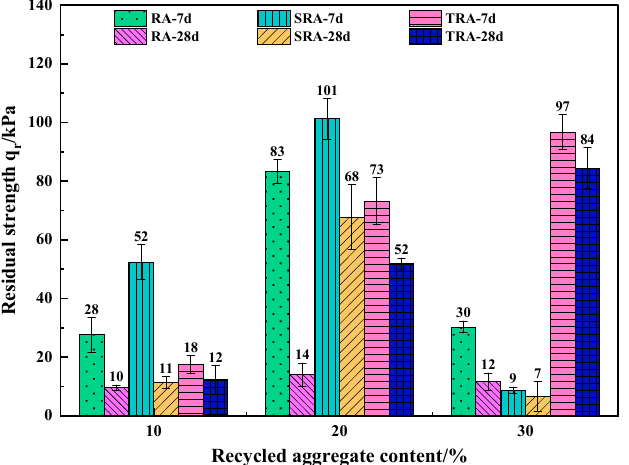
Figure 6. Residual strength of recycled aggregate samples with different particle gradations.